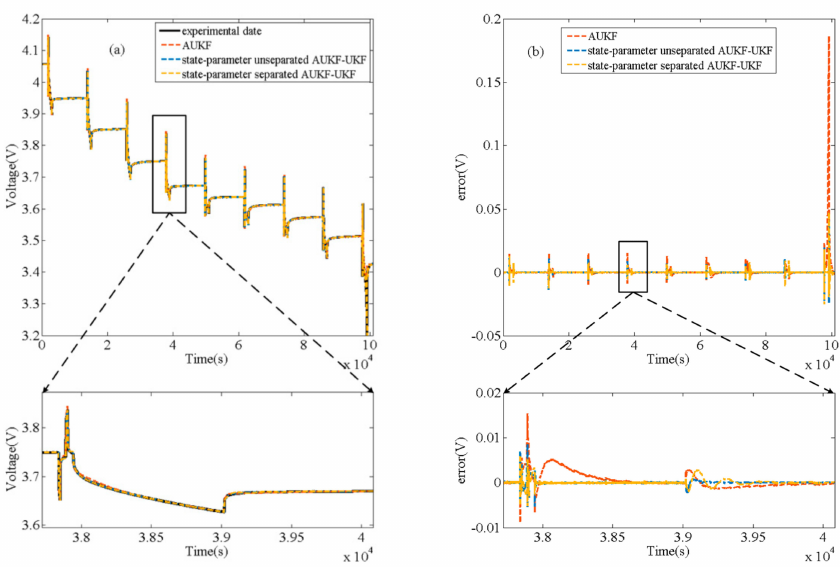
Figure 13. ( a ) The comparison of the u L prediction between three algorithms under HPPC test; ( b ) The comparison of the u L prediction error between three algorithms under HPPC